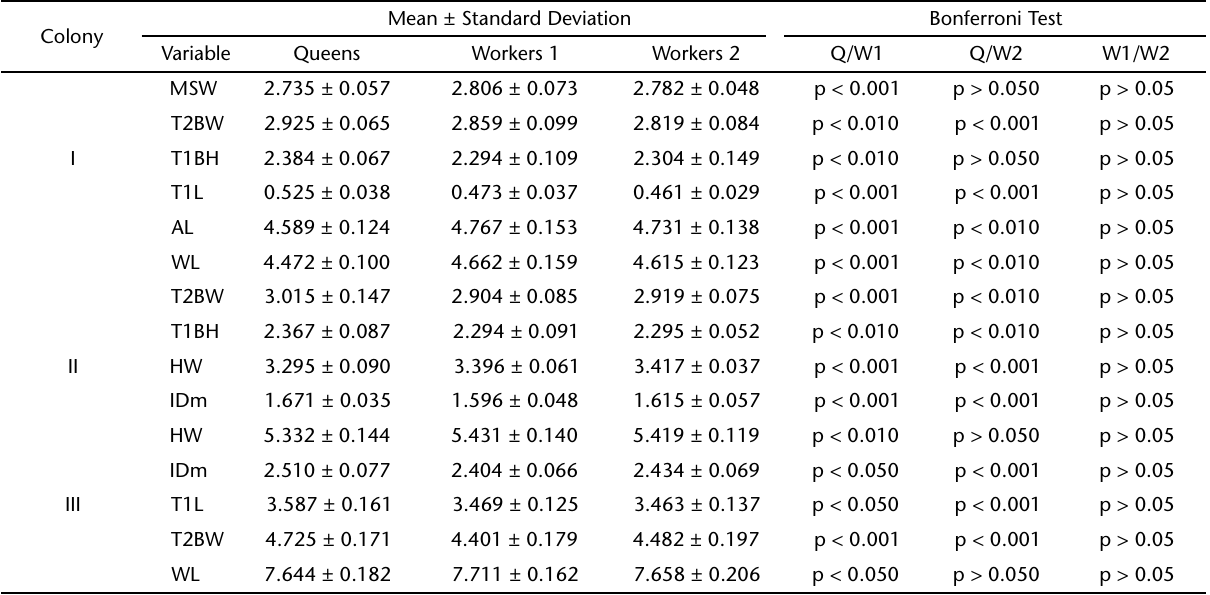
Table II. Mean of morphometric variables (mm) that significantly differed between queens, workers 1 and workers 2, according to ANOVA, with a posteriori test of Bonferroni, for Colony 1 of P. compressa . (Q) Queens, (W1) workers 1, (W2) workers 2.